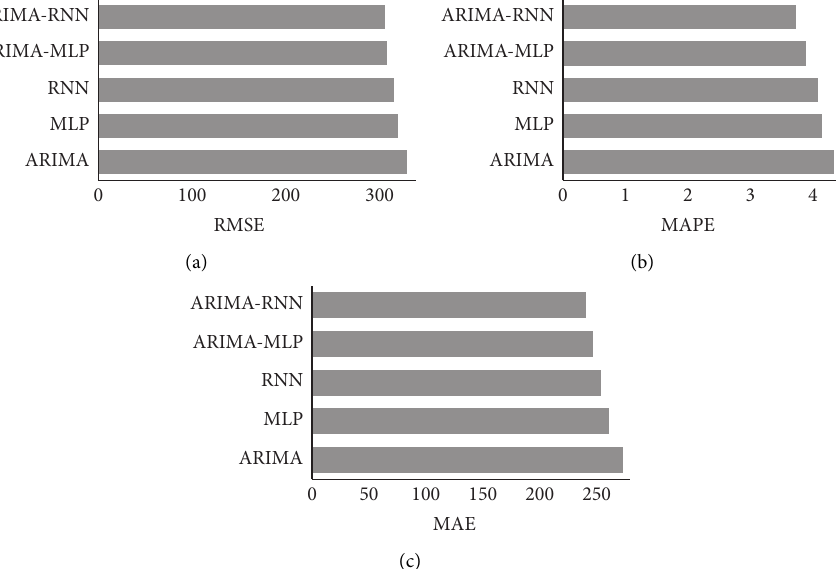
Figure 3: Forecast comparison across different models for Sri Lanka.